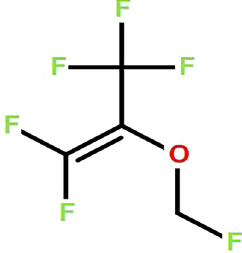
Figure 1: Chemical structure of sevo fl